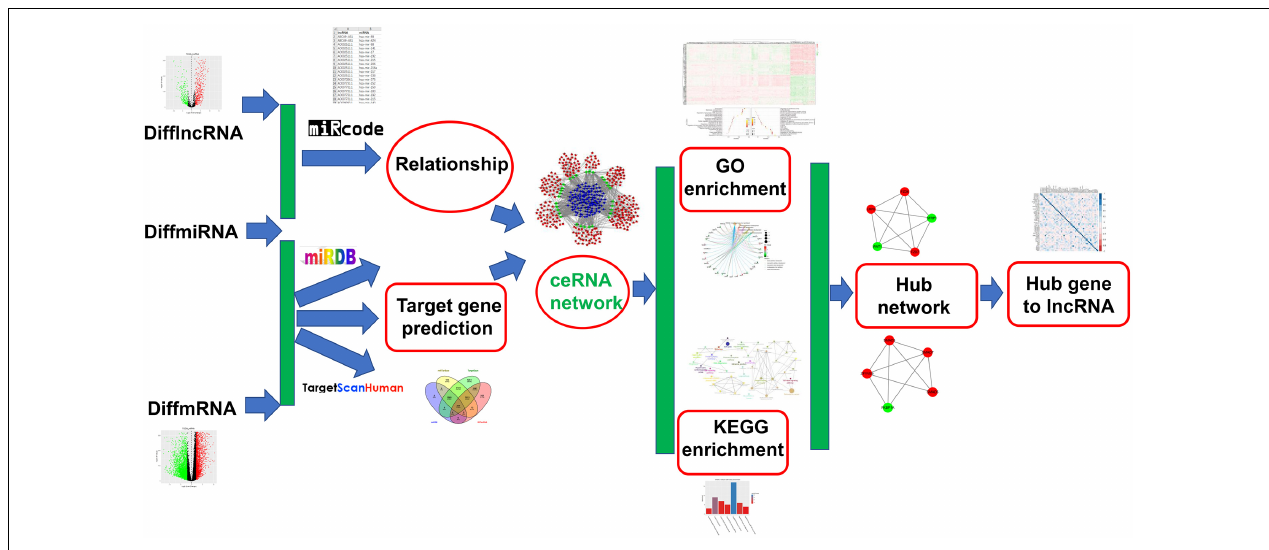
FIGURE 1 | The workflow of this